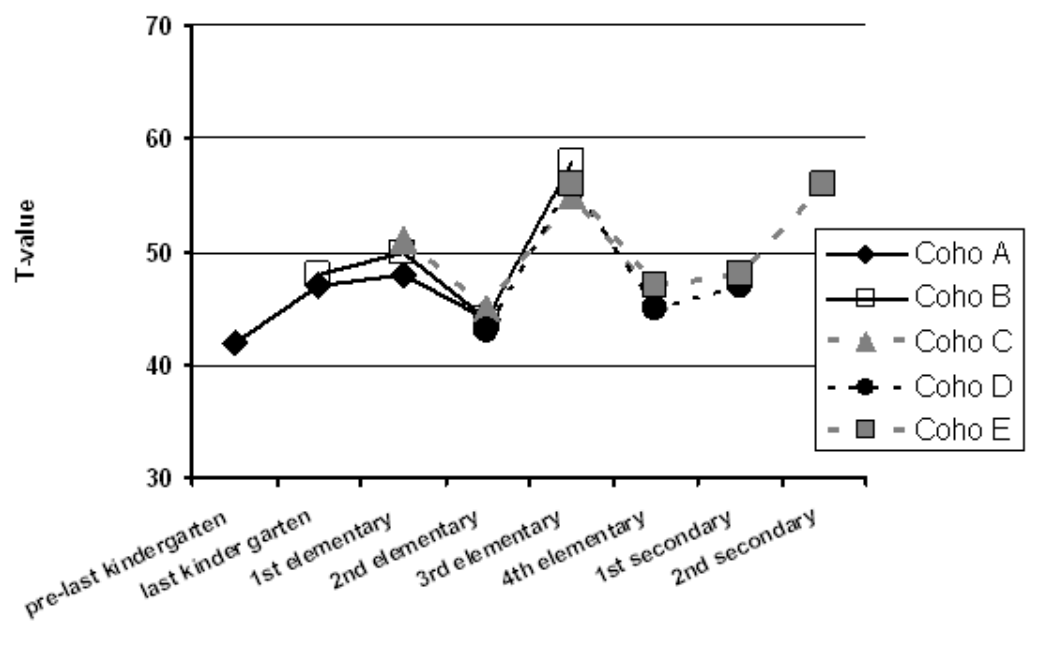
Figure 6. Cross-sequential results on ideational flexibility in the German sample. Europe's Journal of Psychology 2012, Vol. 8(3), 423–448